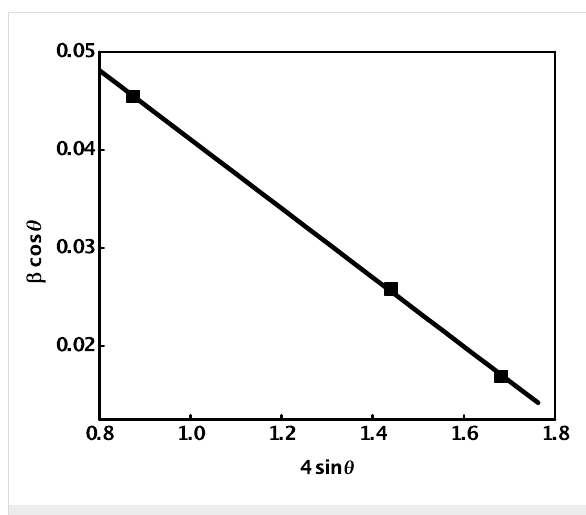
Figure 7: Williamson–Hall plot of PVA-capped CdSe quantum dots, synthesized by the reaction of 2 × 10 − 3 mol dm − 3 Cd(AcO) 2 with 8